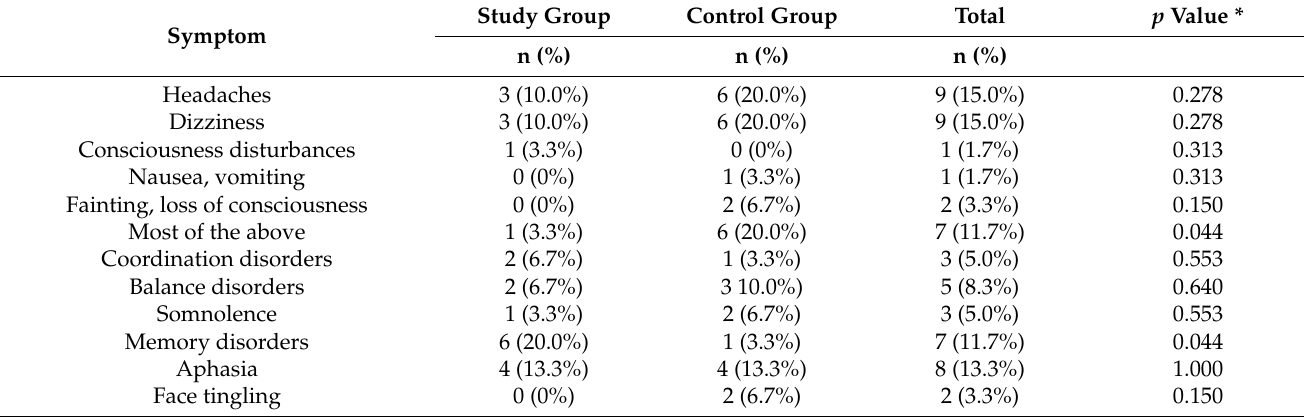
Table 2. First symptoms, frequency, and type of